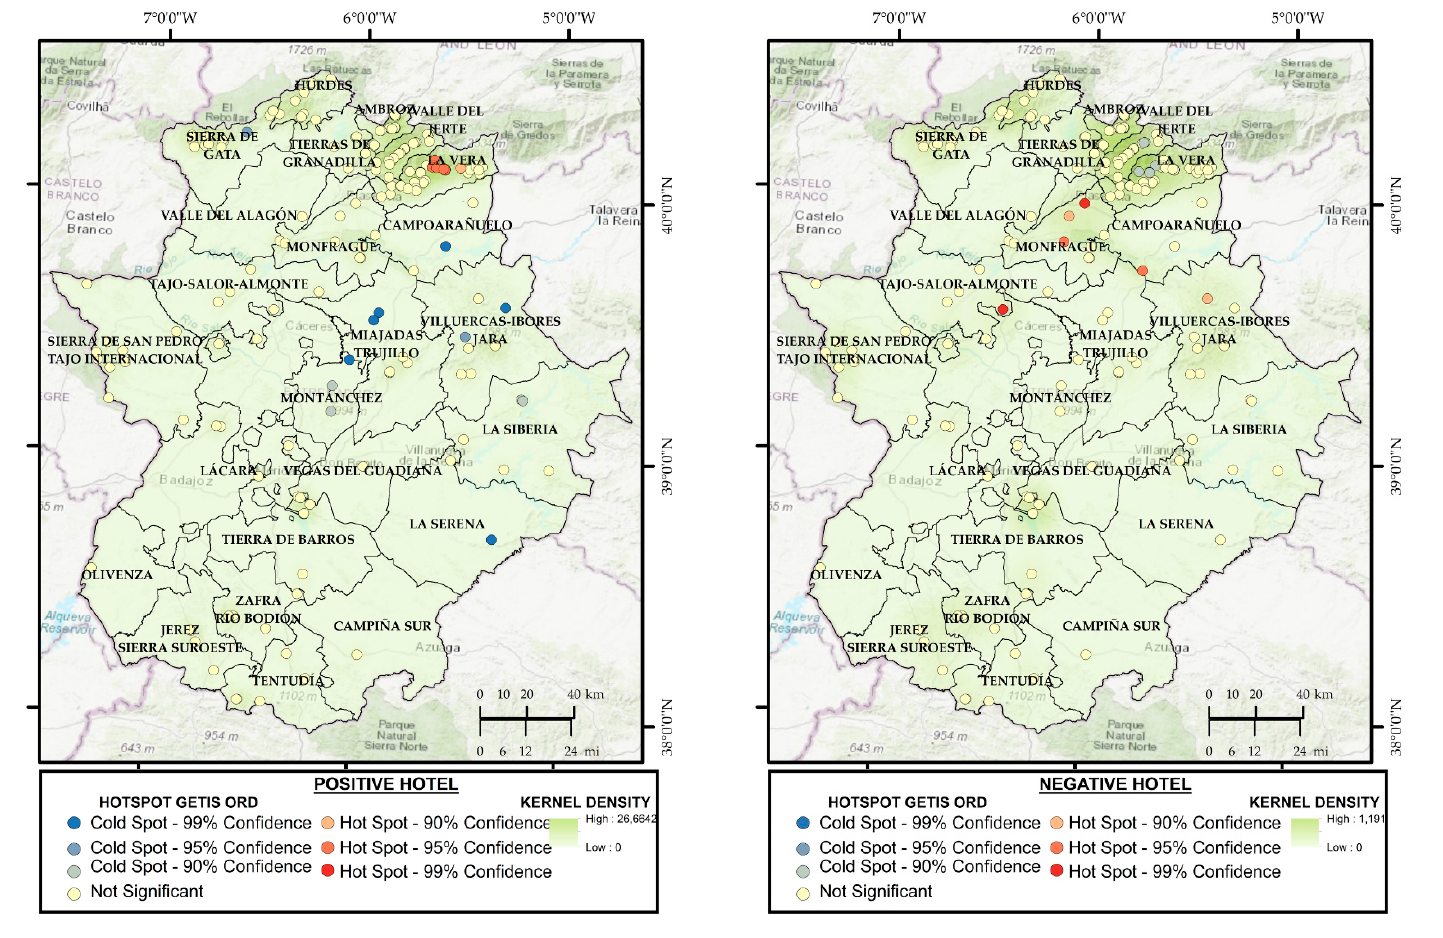
Figure 10. Gi* Getis Ord Hotel Positive ( a ) and Negative ( b ) mentions.